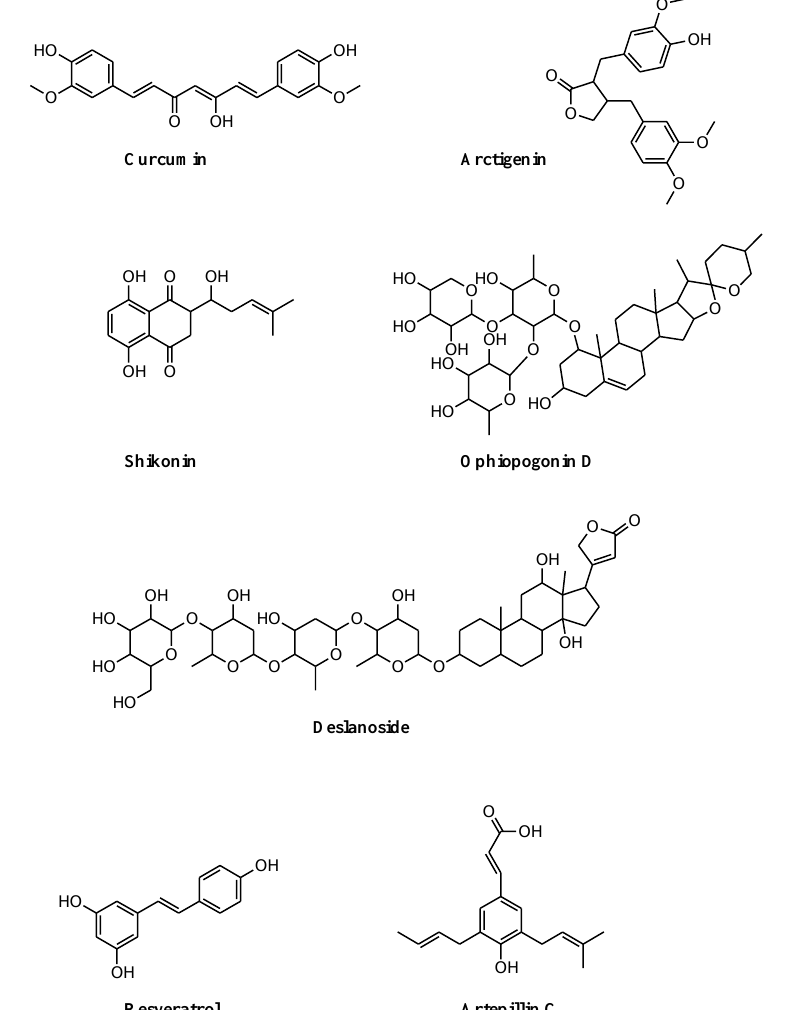
Figure 2. Chemical structures of compounds of natural origin that induce necroptosis in prostate cancer cell lines. These compounds stimulate necroptosis by inducing (i) the dysfunction of mito- chondrial membrane potential, curcumin, and arctigenin; (ii) cell-cycle arrest, shikonin; (iii) FADD stabilization, ophiopogonin D’; (iv) modulation of multiple necroptosis pathways, deslanoside; (v) reactive oxygen species, resveratrol; (vi) RIP1/3 activation following combination with autophagy inhibitors, artepillin C.